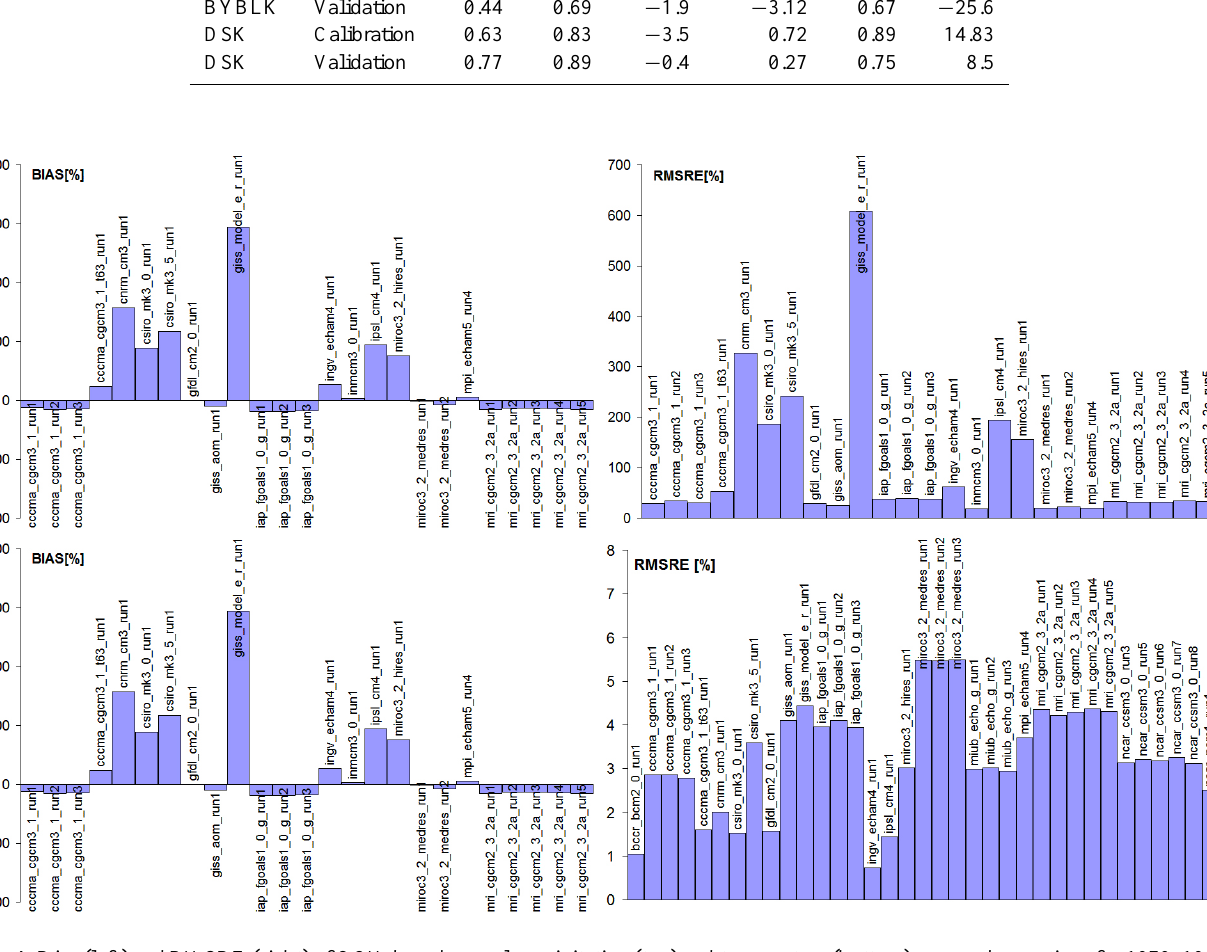
Fig. 4. Bias (left) and RMSRE (right) of GCM based annual precipitation (top) and temperature (bottom) versus observations for 1979–1998 at BYBLK meteorological